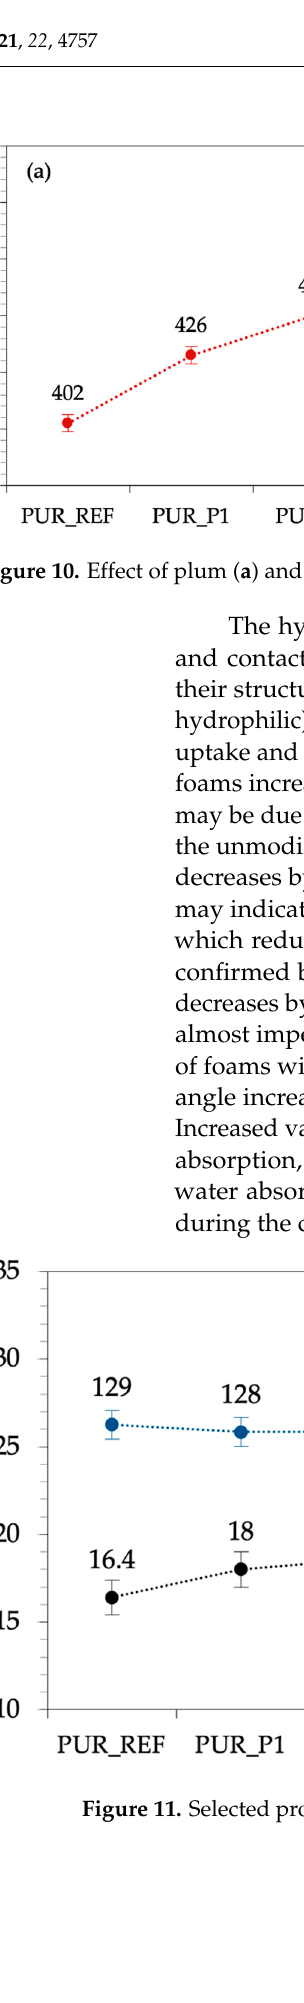
Figure 12. Images of the contact angle measured for ( a ) PUR_REF, ( b – d ) PUR_P, and ( e – g ) PUR_Si-P. 3. Materials and Methods 3.1. Materials •